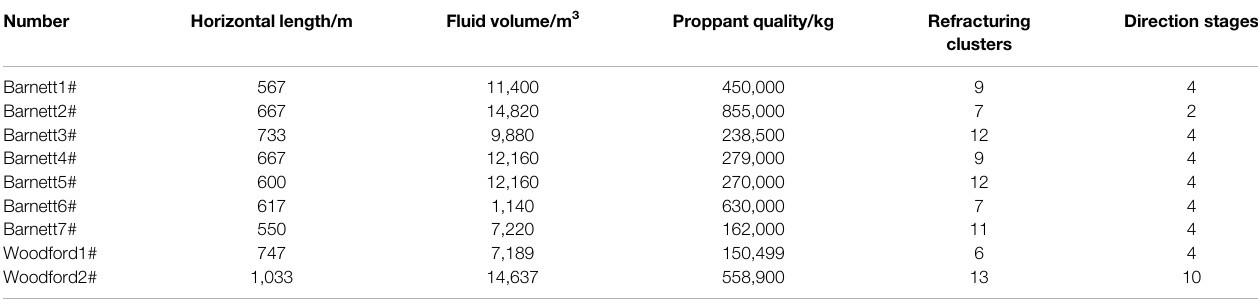
TABLE 1 | Treatment trial data of refracturing wells (Xiao et al., 2020). Number Horizontal length/m Fluid volume/m 3 Proppant quality/kg Refracturing